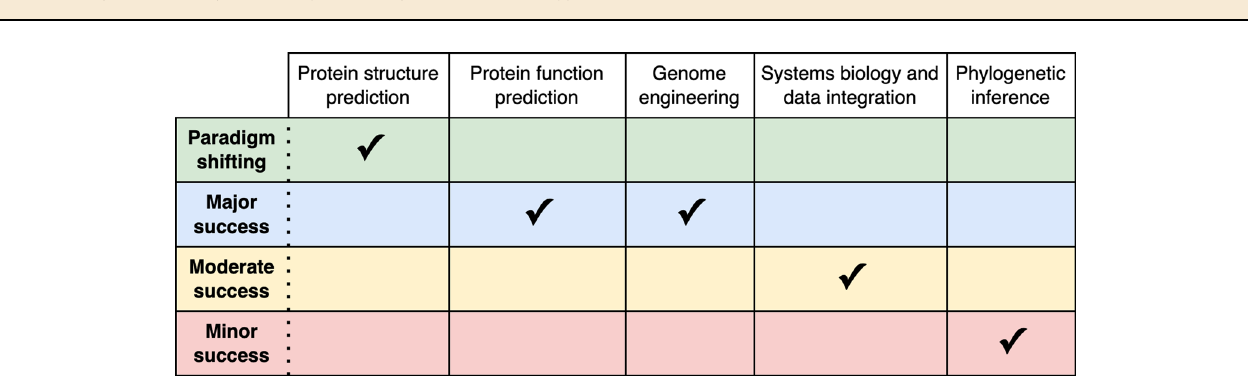
Table 1 Impact of Deep Learning on Computational